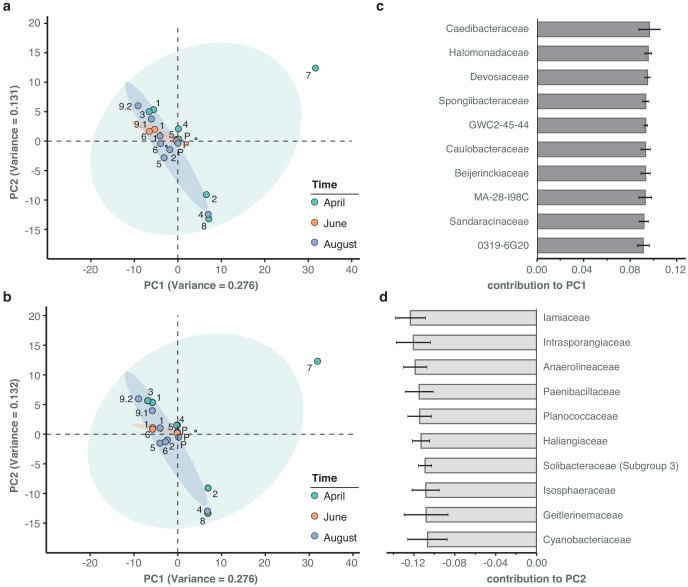
Principal component analysis of river bacterial family compositions.(a–b) PCA with two independent rarefaction sets to 37,000 reads in all freshwater sequencing samples. Numbers and coloured dots indicate locations for each time point. The first and second principal components (PC1 and PC2, combined variance:~41%) robustly capture outlier samples 'April-7' along PC1 and 'April-2', 'August-4' and 'April-8' along PC2. (c–d) Fractional loads of the ten bacterial families most strongly contributing to changes along PC1 (c) and along PC2 (d). Error bars represent standard deviation of these families to the respective PC across four independent rarefactions. Subsequent principal components (PC3 and PC4) are less outlier-driven and depict spatial and temporal metagenomic trends within the River Cam.